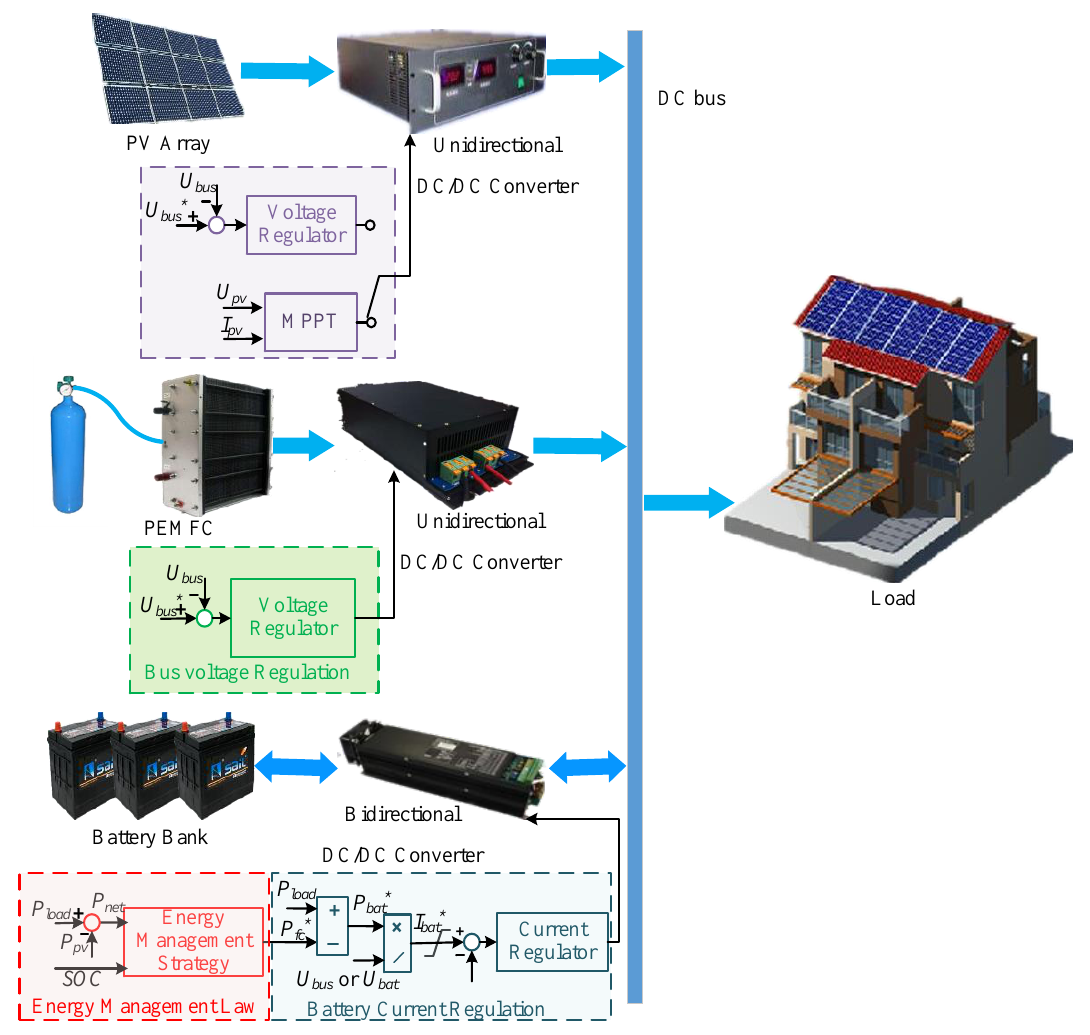
Figure 7. Control structure of the DC microgrid system.